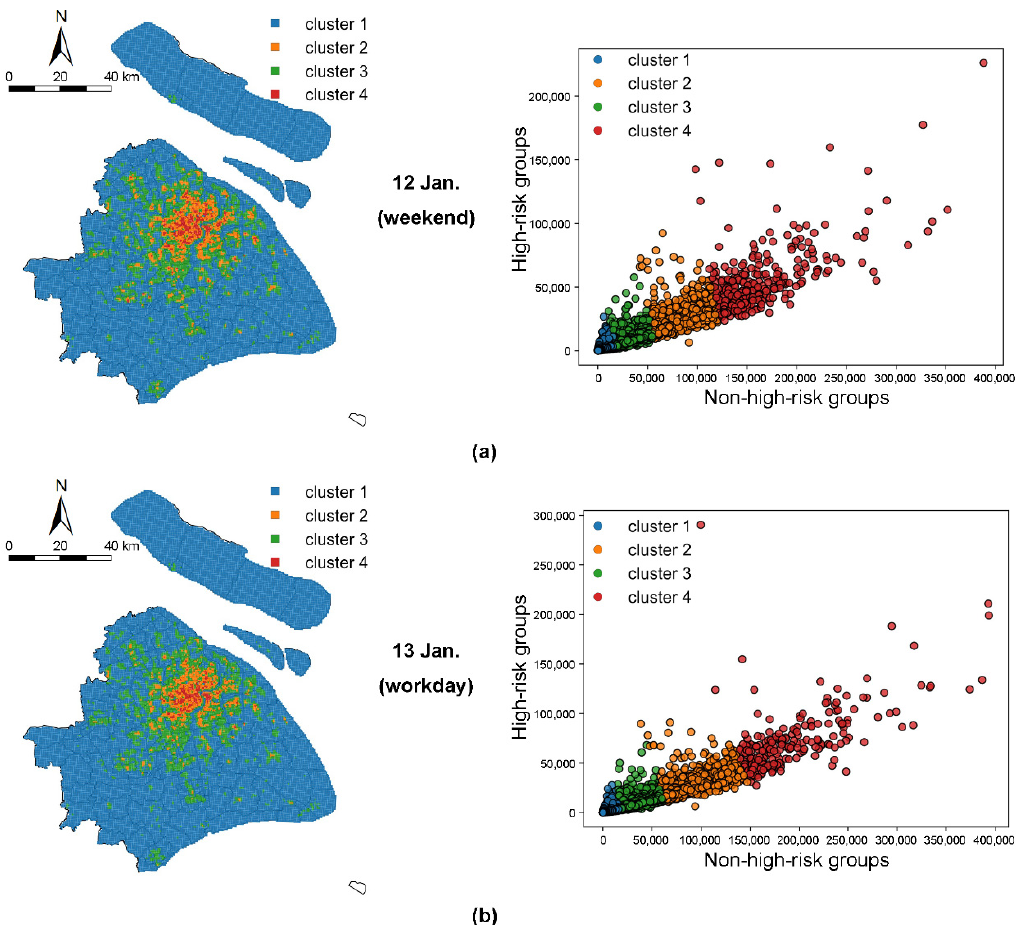
Figure 6. Spatial distribution and scatter plots of clustering results for intranode exposure risk on weekends ( a ) and workdays ( b